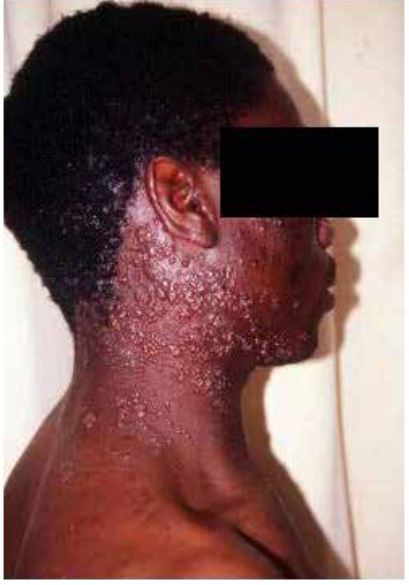
Figure 2. Multidermatomal herpes